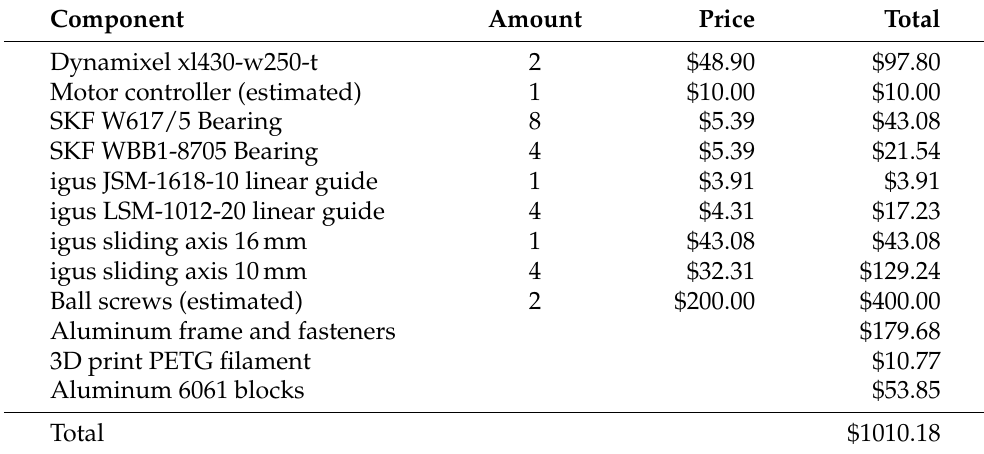
Table 5. Project cost analysis including purchased components and materials. As manufacturing took place in-house, this is not listed here. Some components were already available in the workshop and their original price is not known; the respective costs were